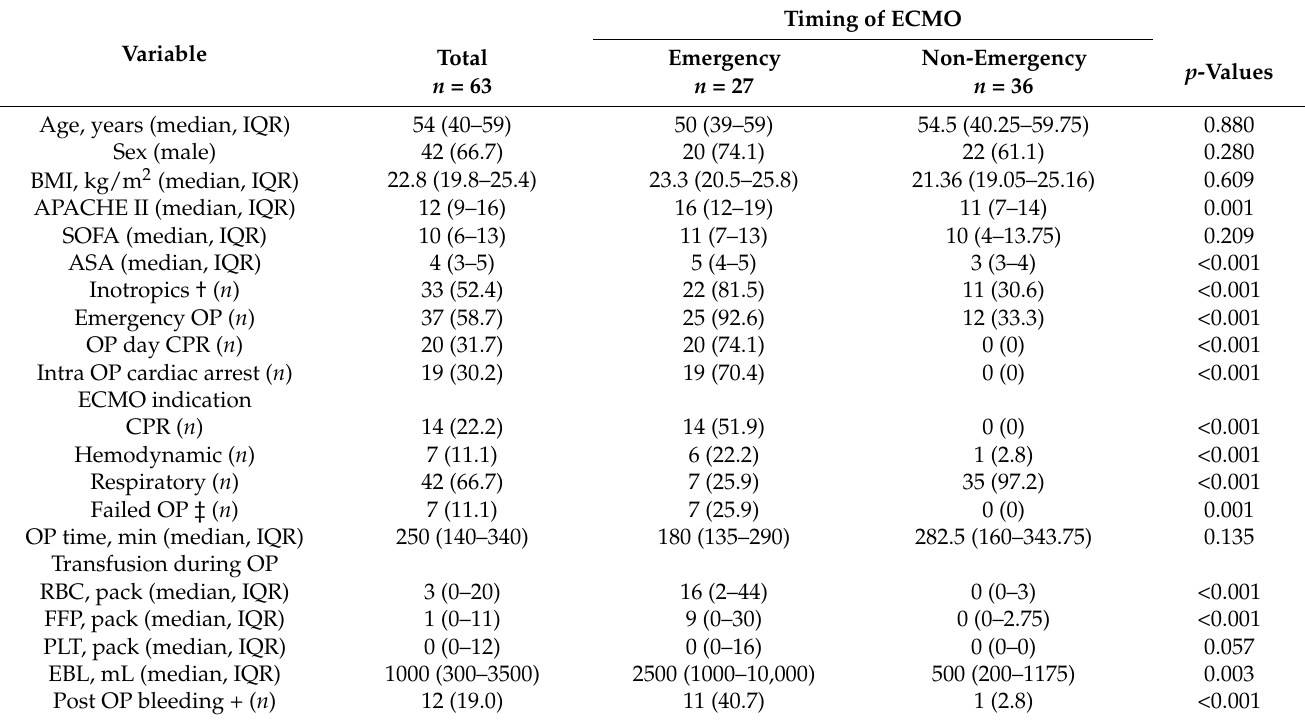
Table 1. Basal characteristics of patients with emergency and non-emergency ECMO